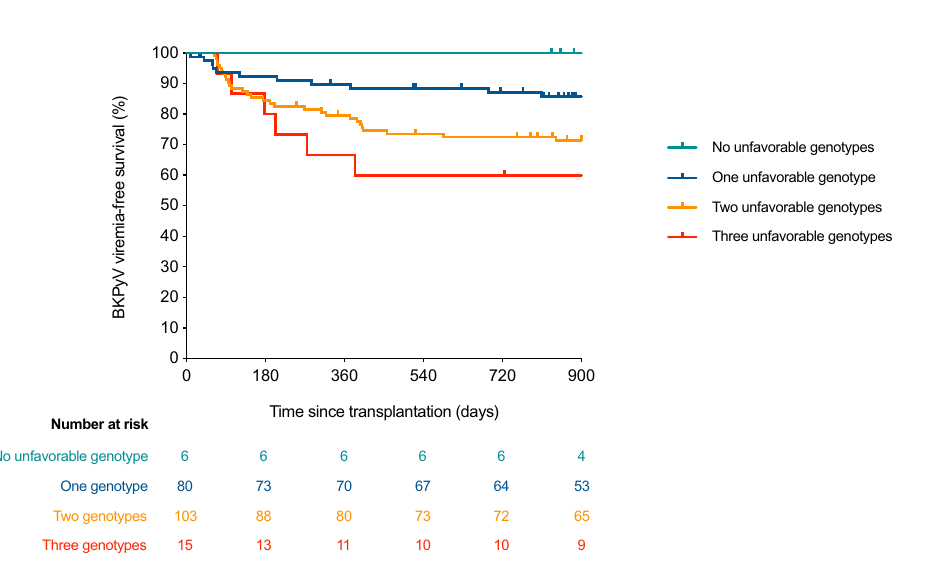
Figure 2. Comparison of Kaplan–Meier BKPyV viremia-free survival curves according to the number of unfavorable genotypes in selected SNPs: 0 (green line), 1 (blue line), 2 (orange line) and 3 unfavorable genotypes (red line) (log-rank P value = 0.008). Unfavorable genotypes were categorized as follow: TG/GG for IL10 (rs1800872), TT for TLR3 (rs3775291), and AA for CD209 (rs4804803). BKPyV: BK